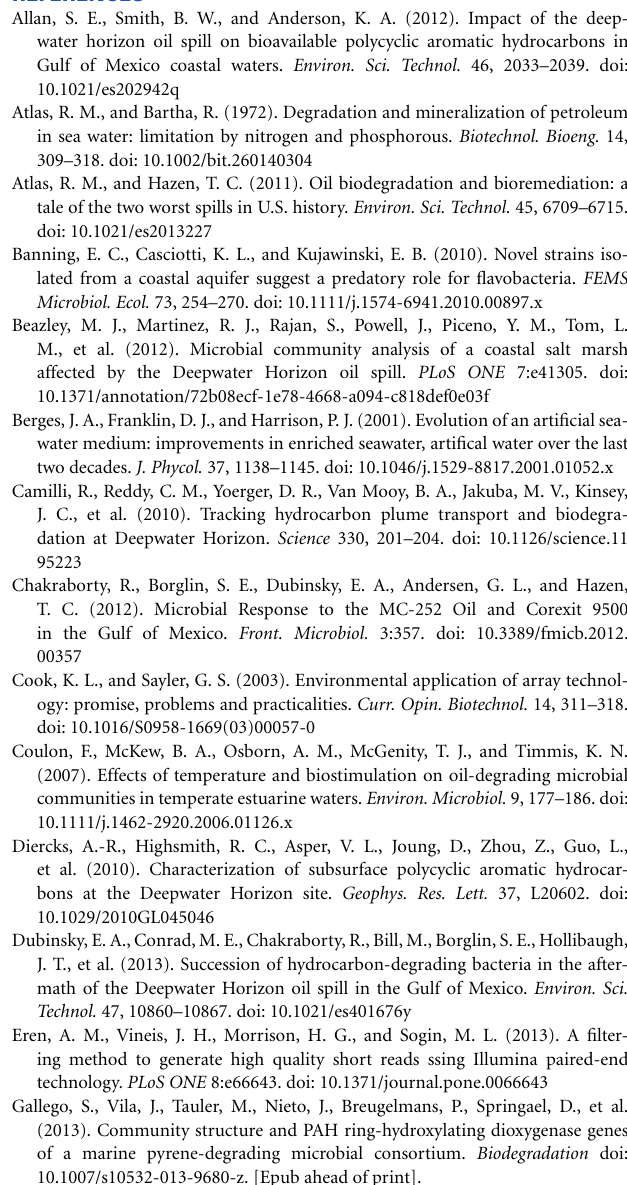
Table S1 | 16S rRNA gene sequence taxonomical diversity, similarity, and evenness in mesocosms. Figure S1 | Diagram illustrating the inclusive metabolic pathways (based on KEGG Pathway Database) representing the genes involved in PAH and hydrocarbon degradation. The genes were determined by functional microarray analysis that showed greater abundance in the month of June at Orange beach (heavily oiled) compared to St. George